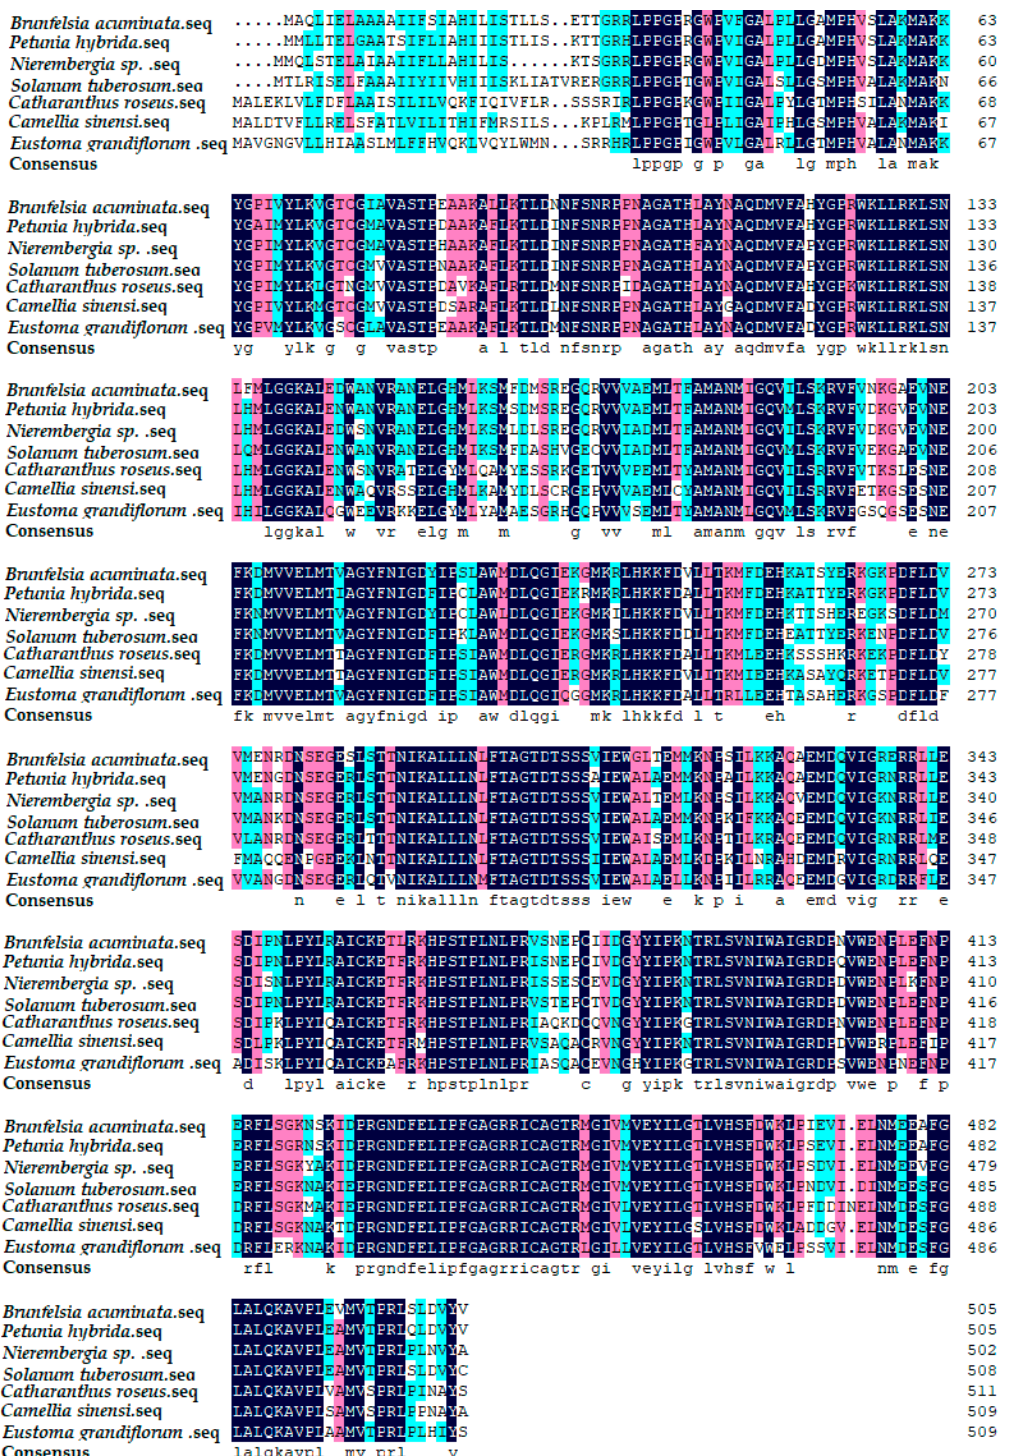
Figure 6. Multiple alignment of amino acid sequences of F3 ′ 5 ′ H from B. acuminata with different plants. Background dark is exactly the same, light-colored part of the same.